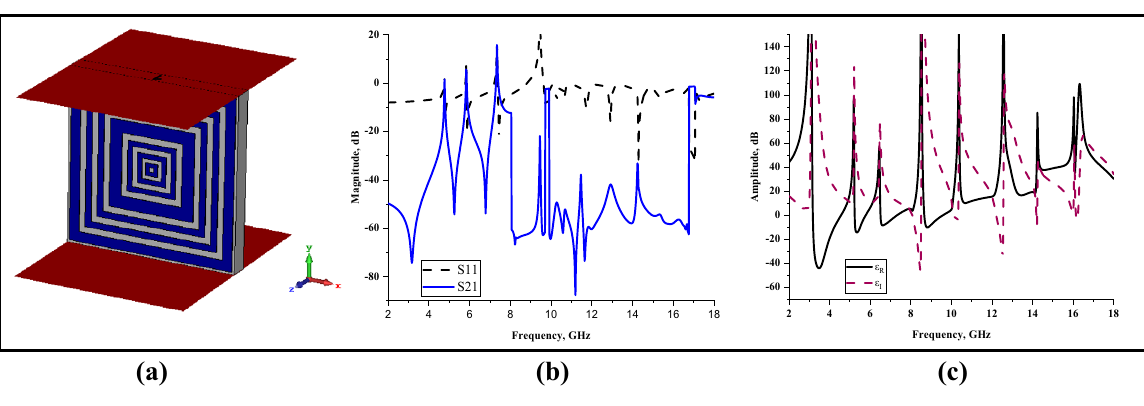
Figure 7. x-axis wave propagation: ( a ) Simulation setup, ( b ) S11 and S21, ( c ) Permittivity.